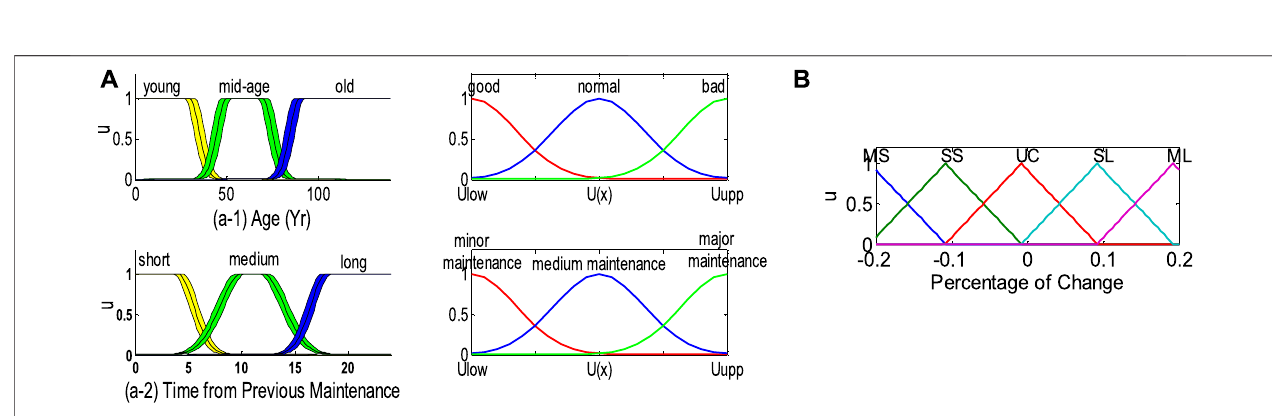
FIGURE6| Membershipfunctionsfortransformers: (A) primaryandsecondary membership functionsofinputs(age,loadfactor,timefrompreviousmaintenance, and working environment); (B) membership functions of output (percentage of change to the transition rates of the Markov model).